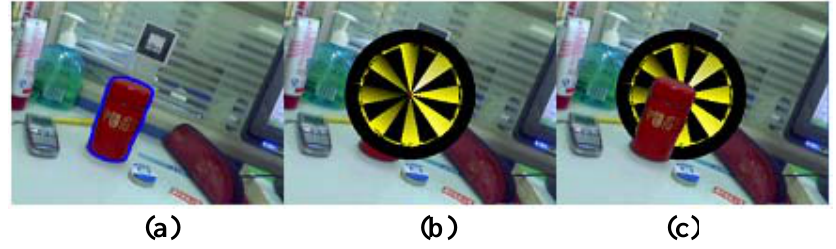
Figure 4. An example of occlusion handling. (a) The tracked contour of the real object. (b) Augmented image with the wrong relationship between the real and virtual objects. (c) Synthesized image with the correct relative